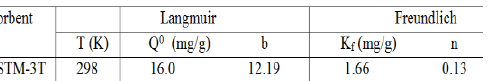
Table 6. Langmuir and Freundlich constants for PSTM-3T at 298